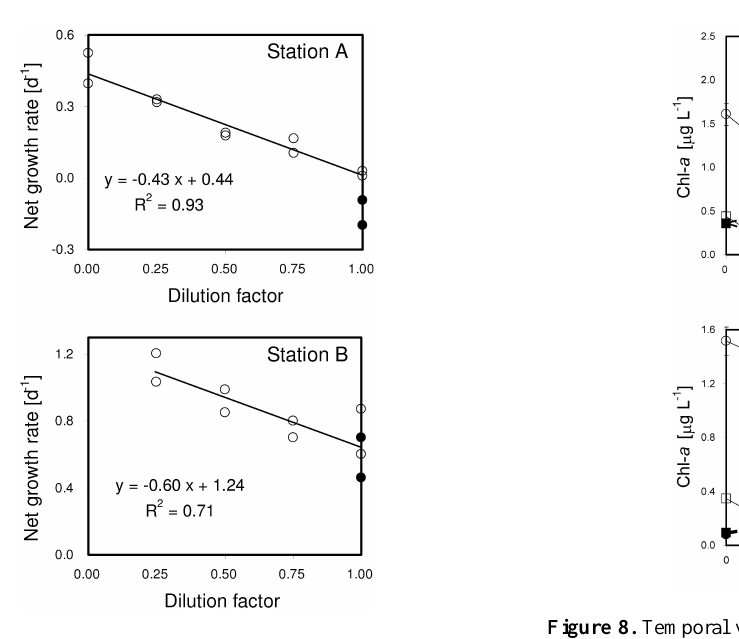
Figure 7. Dilution experiment plots of phytoplankton net growth rates against the dilution factors for stations A and B. Filled circles are net growth rates of the raw seawater without nutrient enrich- ment.